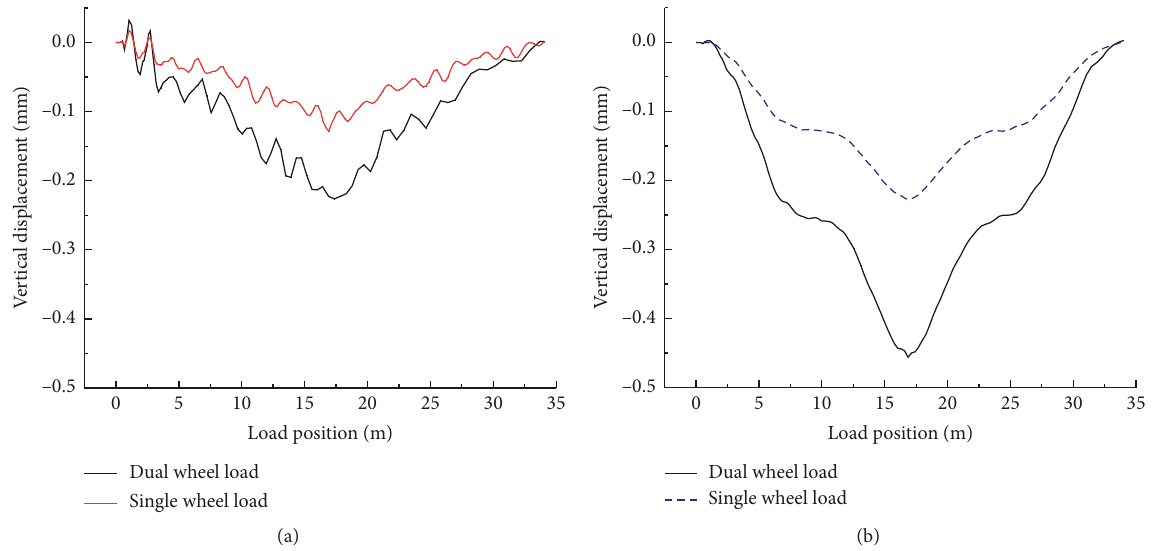
Figure 6: Comparison of vertical displacement on the surface of the bridge deck pavement of both models. (a) CWBG bridge. (b) CSWBG